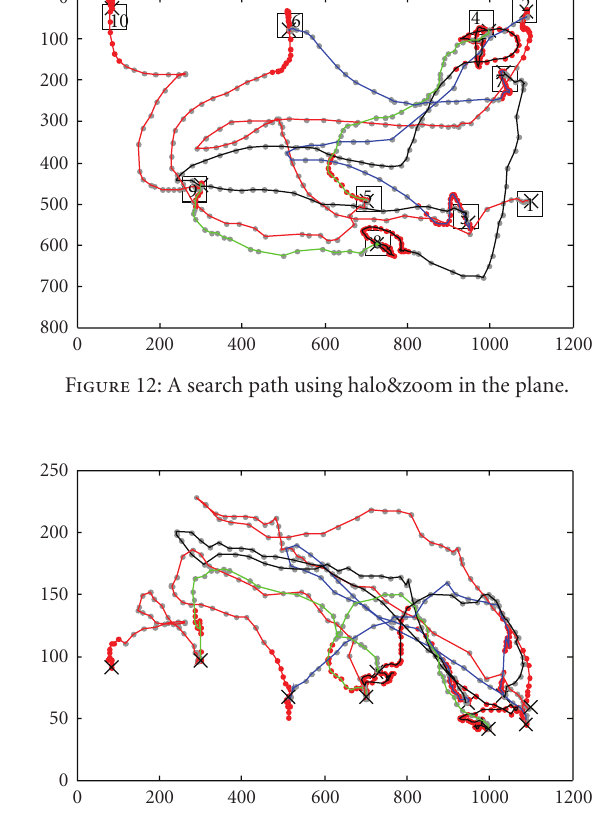
significant e ff ects of zoom ( F 1,62 = 7 . 02, p < 0 . 01), and halo ( F 1,62 = 15 . 33, p < 0 . 01). Within the grid method, no interaction e ff ects were